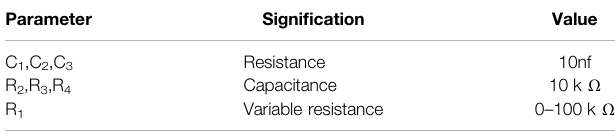
TABLE 1 | Linear element parameters for